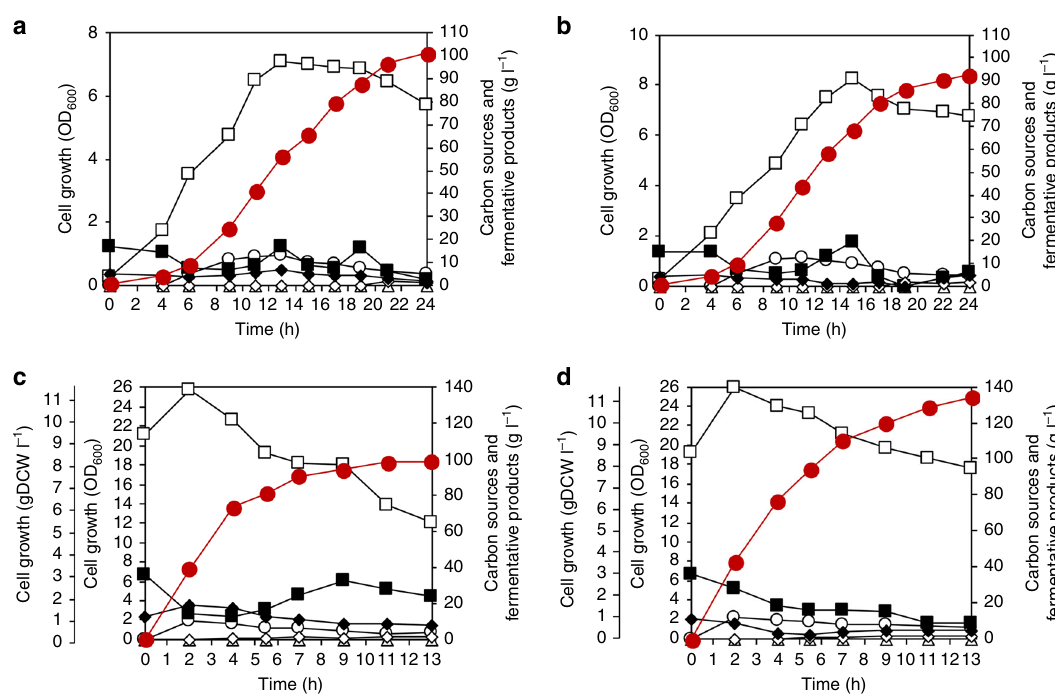
Fig. 3 Fed-batch fermentation pro fi les of various metabolically engineered M. succiniciproducens strains. Fed-batch fermentations of the a PALKcgmdh and b PALKmsmdh G11Q strains were carried out in CDM using glucose and glycerol as dual carbon sources. Fed-batch fermentations of the c PALK and d PALKcgmdh strains were carried out using glucose and glycerol with increased initial cell mass (OD 600 = 21.1 and 19.3, respectively). Symbols: White square, cell growth; red circle, SA; black square, glucose; black diamond, glycerol; white circle, pyruvate; white diamond, acetate; white triangle, formate. Fermentations were all performed in duplicate ( n = 2 independent experiments). The fermentation pro fi le shown here represents the result of one fed- batch culture, whereas the result of another reproduced fed-batch culture is shown in Supplementary Fig. 15. Source data are provided as a Source Data fi